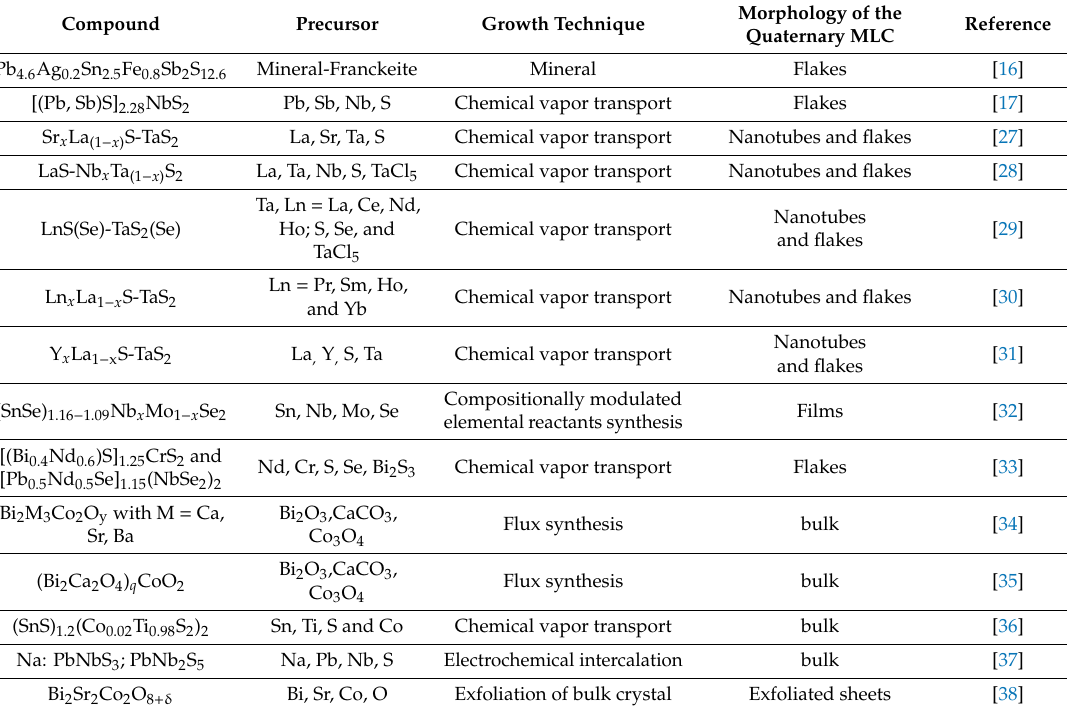
Table 1. Summary of the data for quaternary misfit layered compounds: synthesis technique, elements and morphology of the